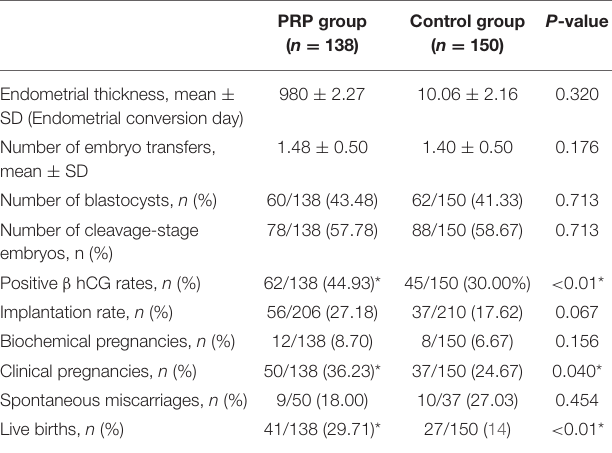
TABLE 2 | Clinical characteristics of the participants with RIF